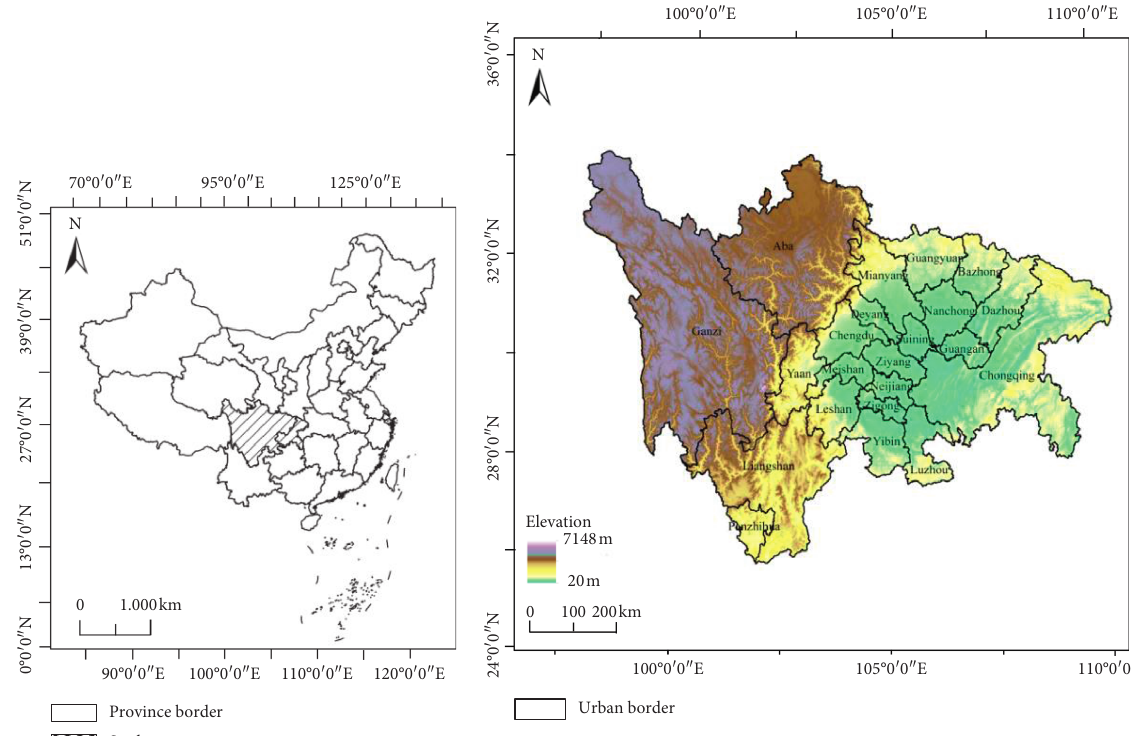
Figure 1: The location and elevation of the study